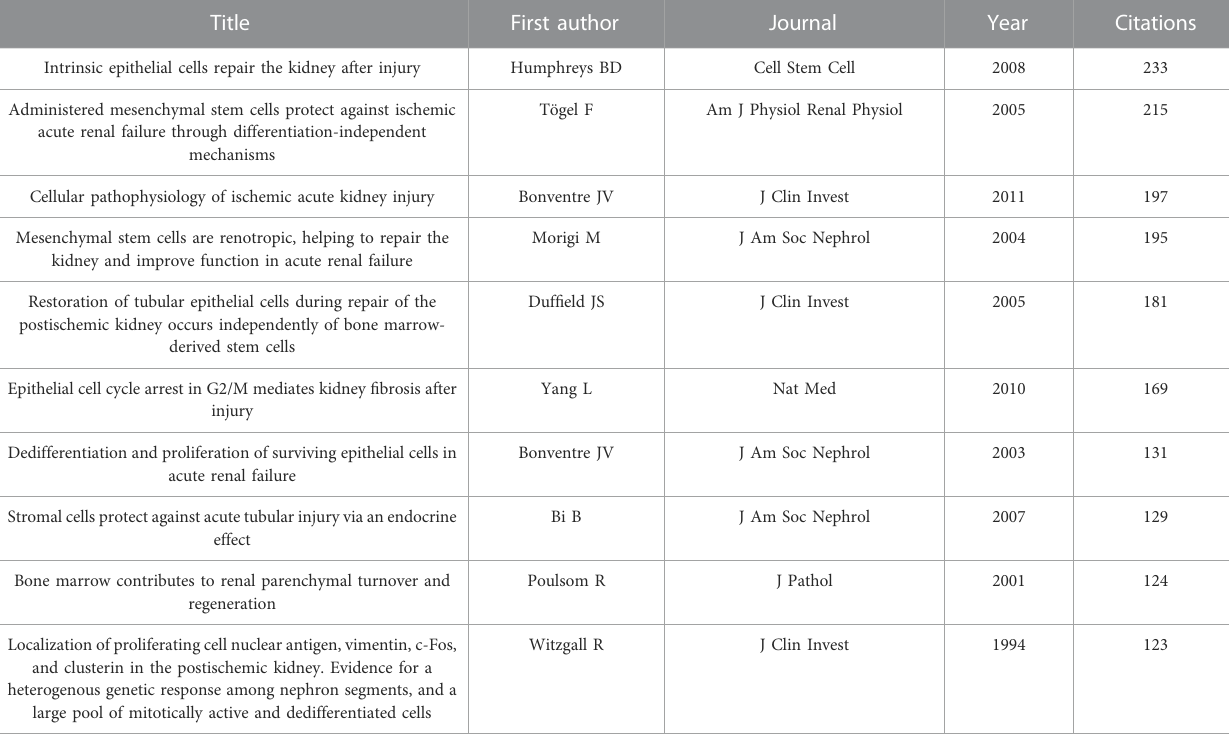
TABLE 5 The top 10 co-cited references involved in kidney repair in